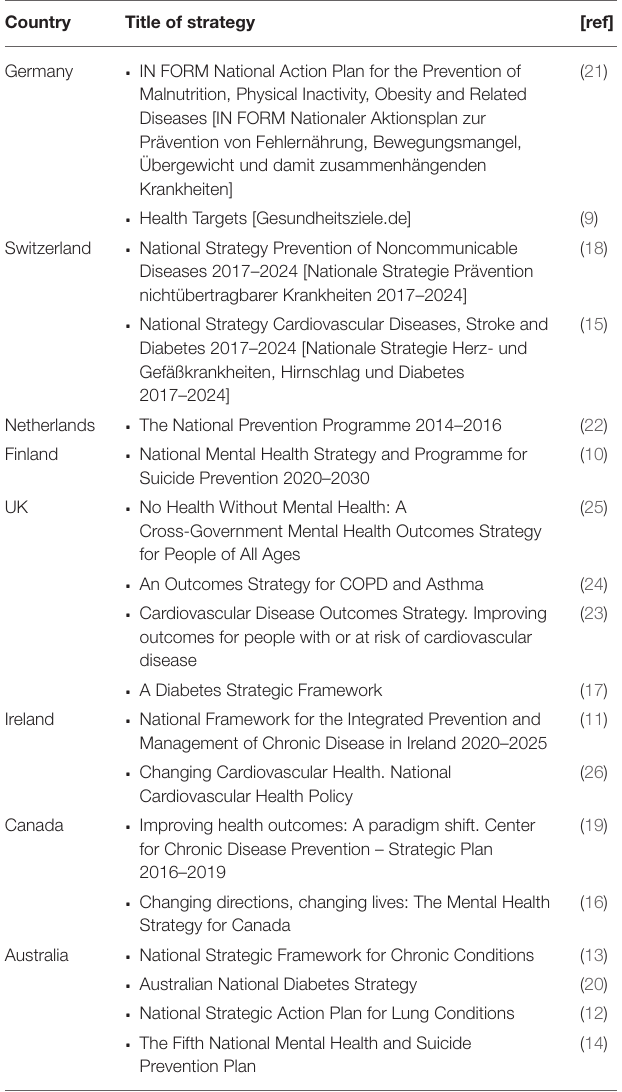
TABLE 2 | Included countries and strategies ( n =